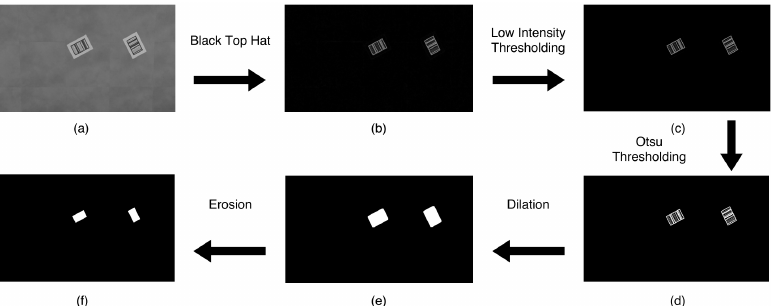
Figure 3. Barcode detection: ( a ) grayscale input image, ( b ) result after black top-hat transform, ( c ) result after low-intensity thresholding, ( d ) result after Otsu thresholding, ( e ) result after dilation, ( f ) result after erosion and final result.